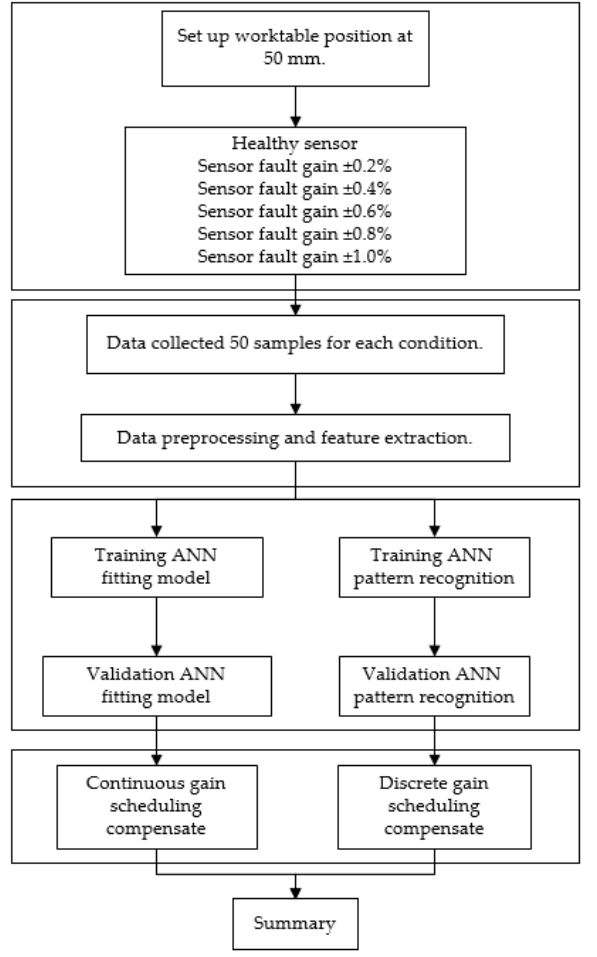
Figure 16. Process flow of the experiments.